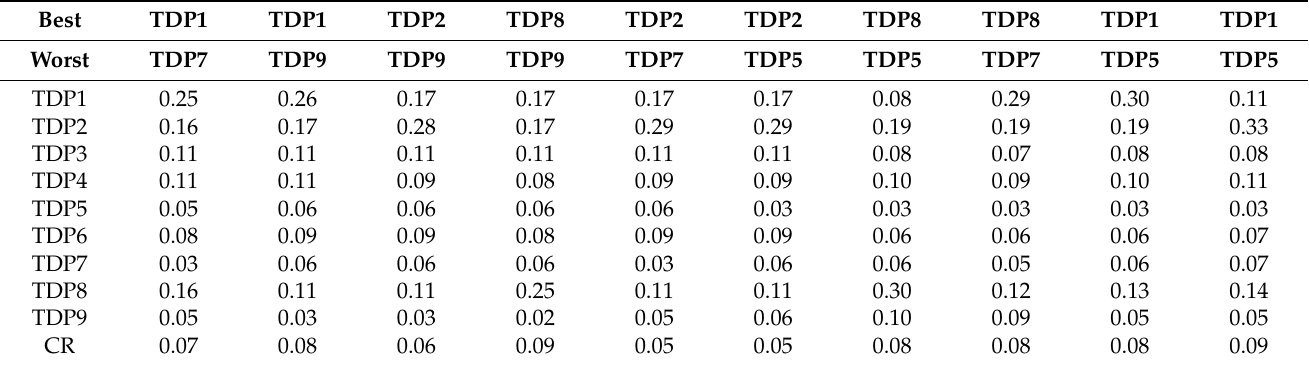
Table 6. Best and worst Technology 4.0 driven warehouse practices along with the optimal weights from each expert.